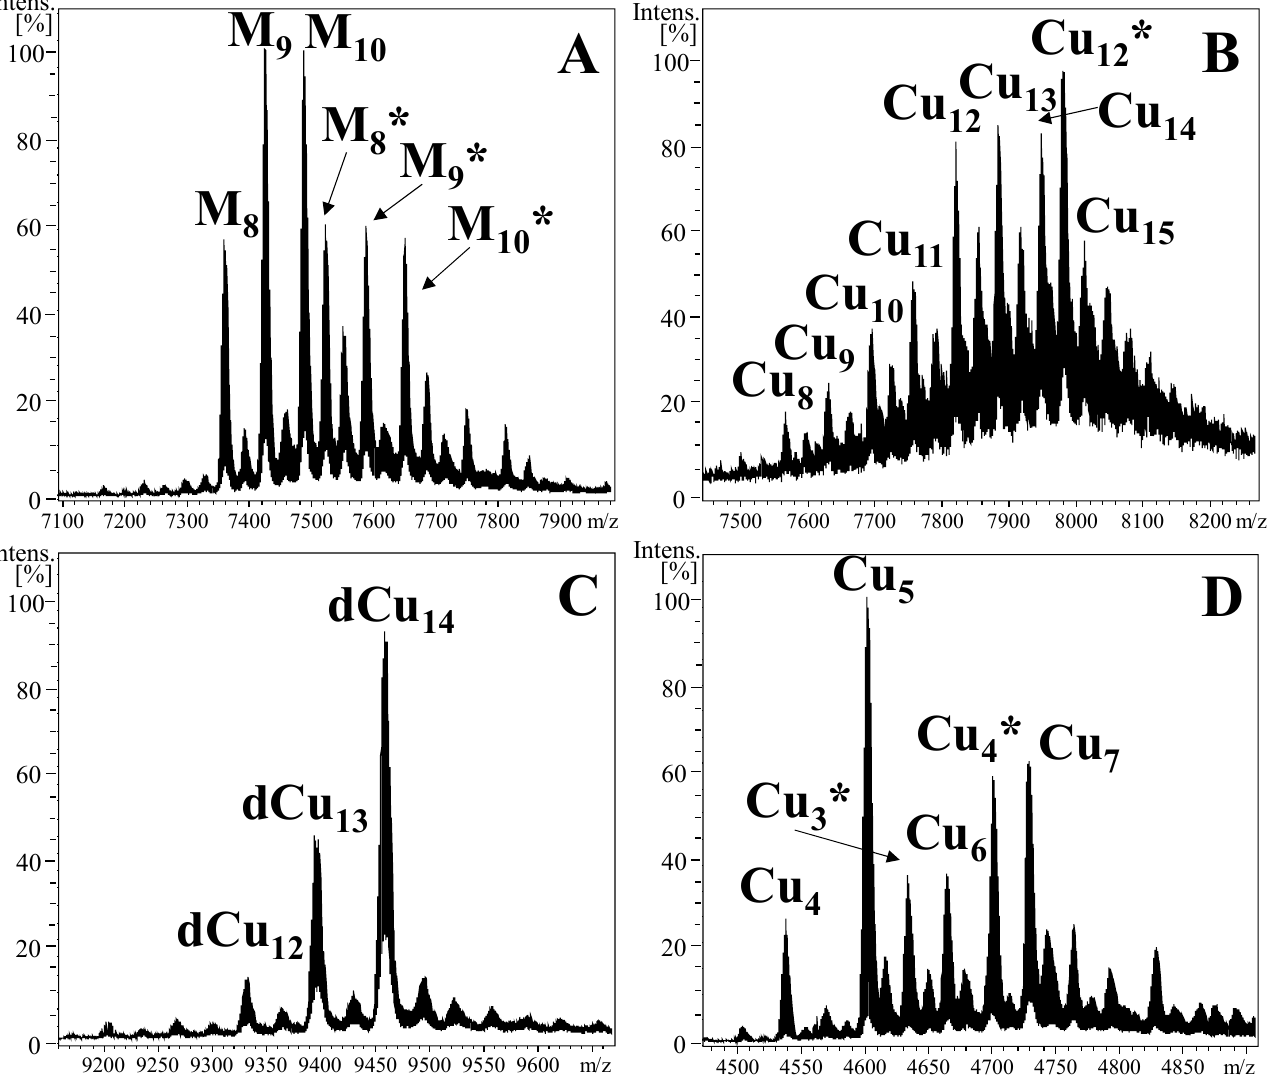
Figure 5. Deconvoluted ESI–MS (pH 7.0) spectra of ( A ) Cu-NpeMT1, ( B ) Cu–NpeMT2, ( C ) Cu- β 3NpeMT2 type 1, and ( D ) type 2. M in panel A stands for (Zn + Cu)–NpeMT1 complexes. Species with * correspond to metal complexes formed by glycosylated-MTs and species with d- correspond to dimeric complexes.